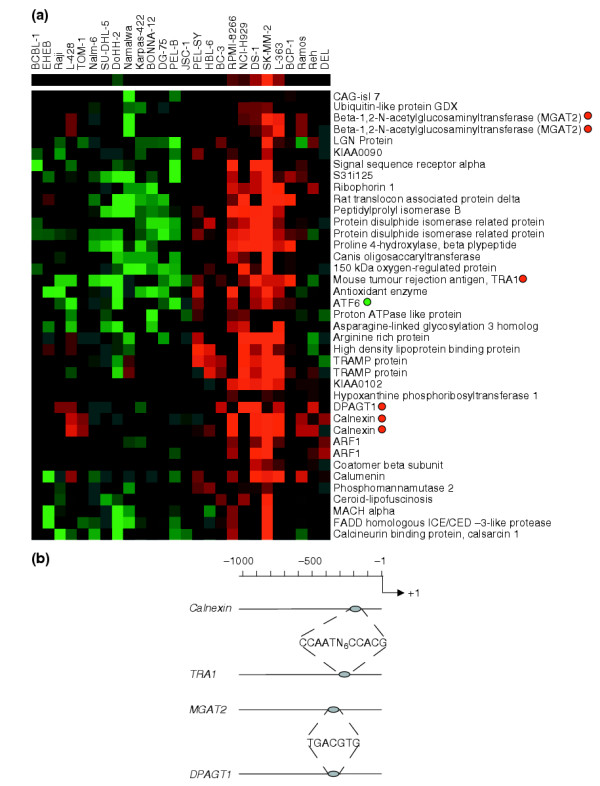
Genes involved in the ER/UPR. (a) Visualization of the ER/UPR consensus cluster using Cluster and Treeview. The ATF6 gene is indicated by a green circle. Gene names indicated by red circles represent those genes whose upstream 1,000-bp regions contain (b) the endoplasmic reticulum stress response element (ESRE), namely, calnexin and TRA1, or unfolded protein response element (UPRE) namely, DPAGT1 and MGAT2.